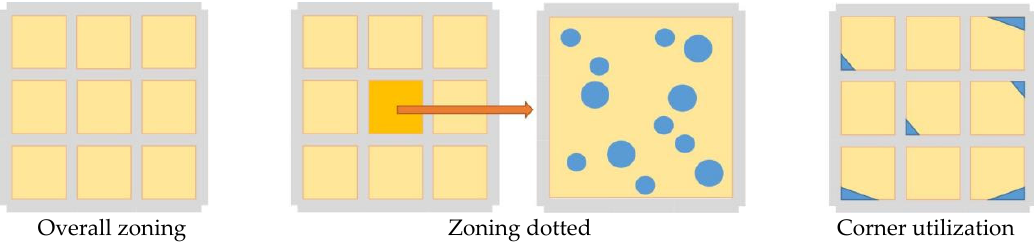
Figure 13. Characteristics of the regional layout of urban parking facilities.